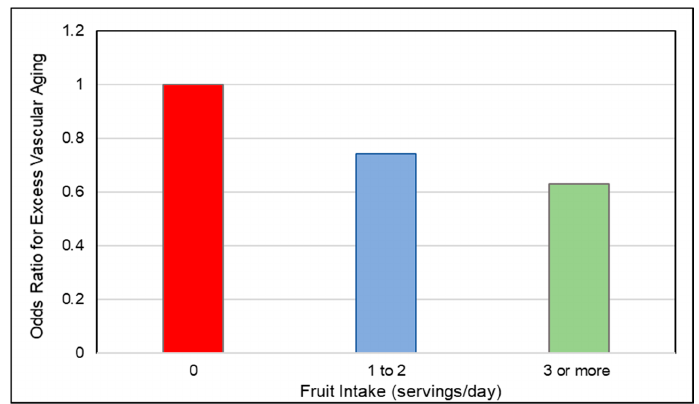
Figure 8. Association between the number of fruit servings/day and excessive vascular age from pooled estimates of World Health Organization (WHO) and US National Health and Nutrition Examination Survey (NHANES) data among adults aged 30–74 years ( p = 0.038)